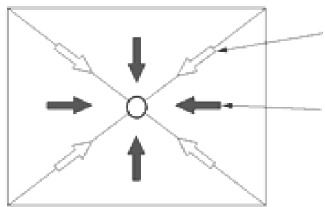
Fig. 9. Scheme of junction of roof slopes in place of rain water gutters